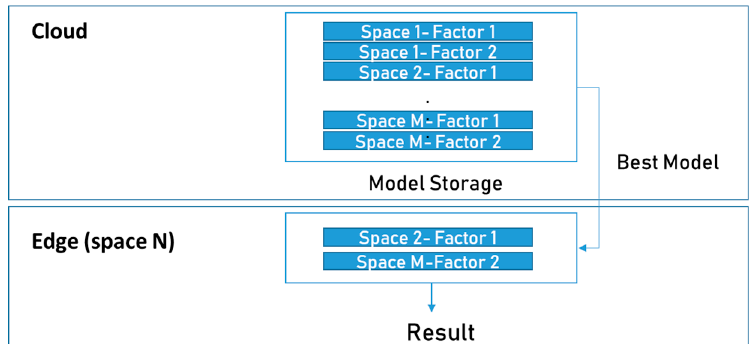
Figure 3. Simple model selection flow to find the most proper model. Algorithm 1. Model